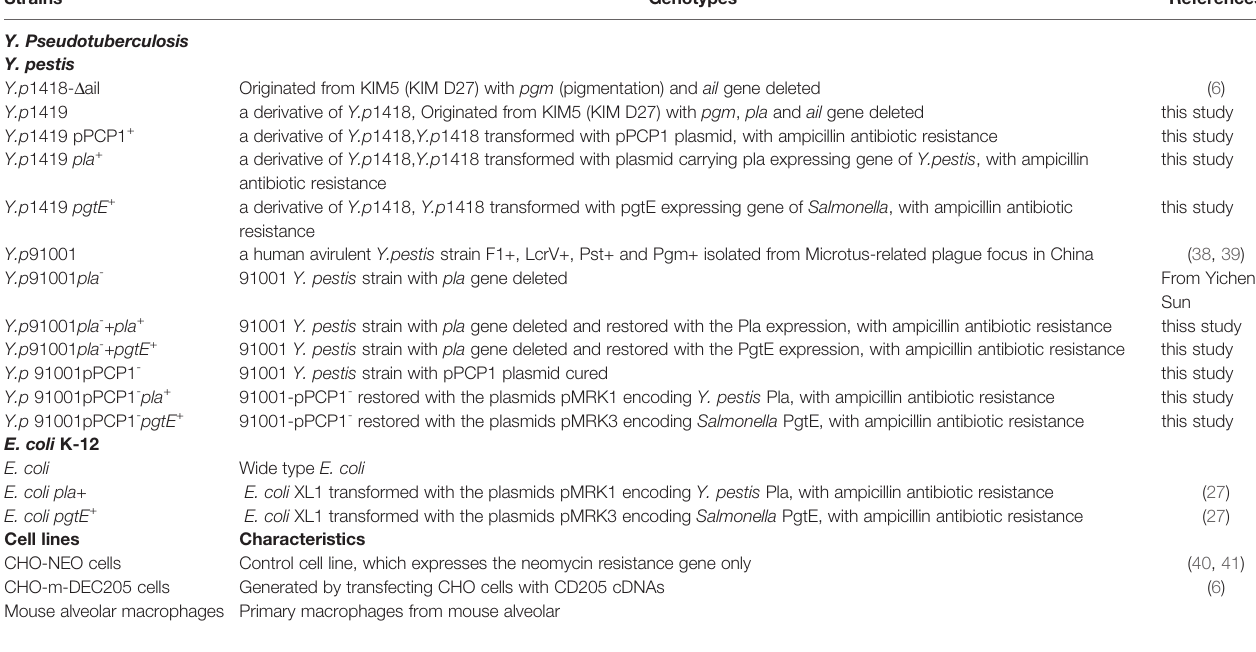
TABLE 1 | Bacteria strains and cell lines used in the study.